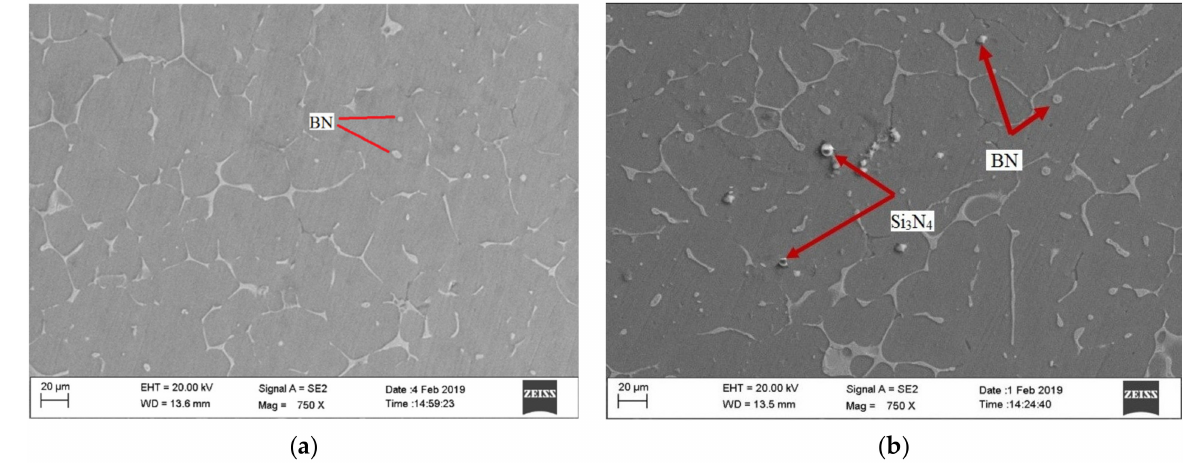
Figure 3. SEM micrograph of AMMC samples: ( a ) S3; ( b ) S8.